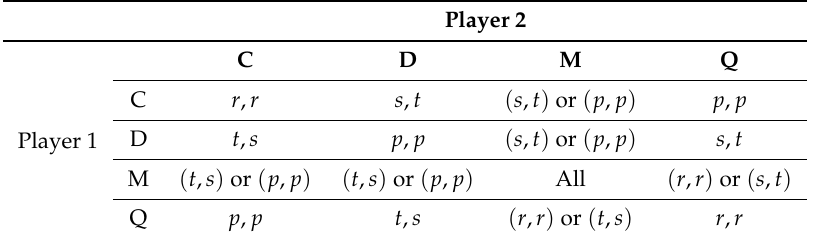
Table 5. The payoff matrix for the quantum PD game, where players can choose to apply four different actions. C stands for cooperate, D for defect, M for the miracle move, and Q for the Q move.